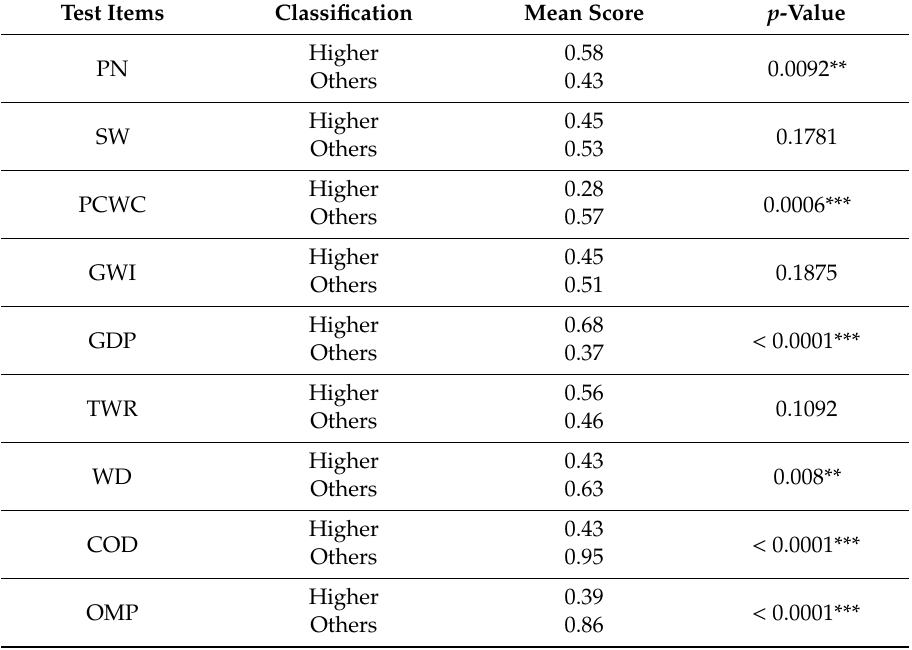
Table 10. The Wilcoxon test on all test